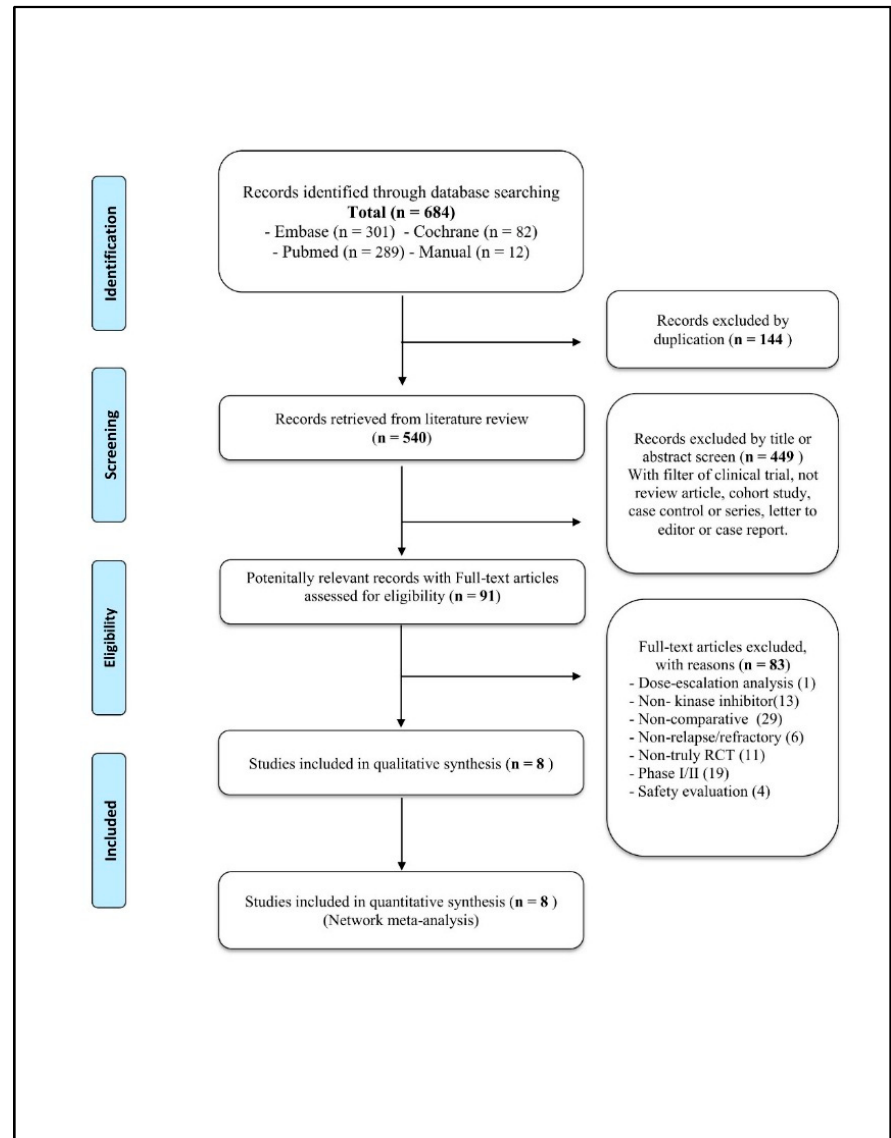
Figure 1. Preferred Reporting Items for Systematic Reviews and Meta-Analyses (PRISMA) flowchart of refractory / relapse chronic lymphocytic